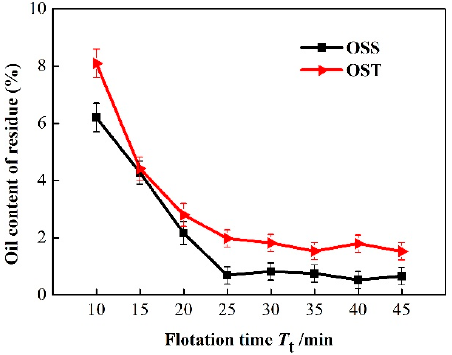
Figure 3. The oil content of residue changing with flotation time. Flotation conditions: C c = 400 mg/L, T p = 33 °C, R s = 1340 r/min, L/OS = 12:1. T p = 33 ◦ C, R s = 1340 r/min, L/OS =